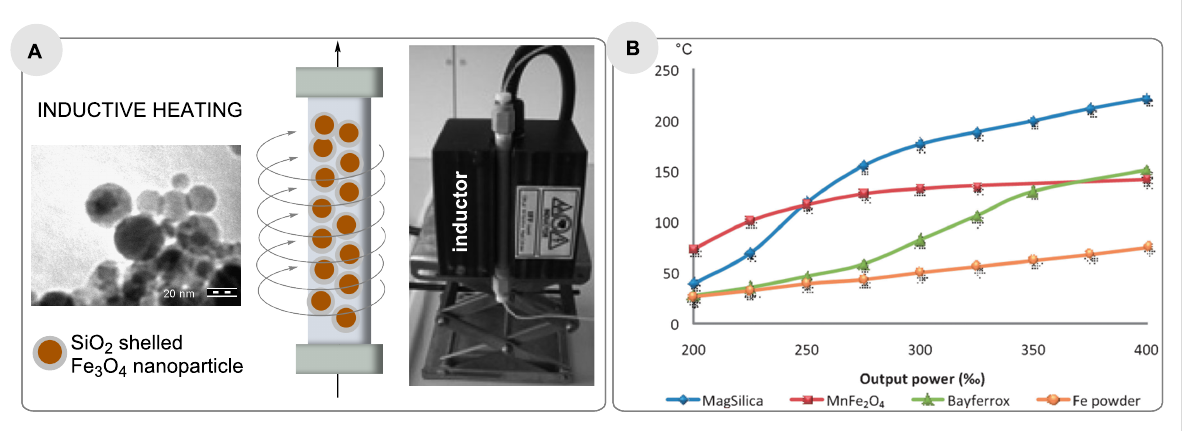
Figure 4: A. Flow reactor filled with magnetic nanostructured particles (MagSilica TM ) and packed bed reactor embedded in inductor (right); B. heating profile of different materials exposed to an electromagnetic field. Heating profiles of MagSilica TM , MnFe 2 O 4 , Bayferrox TM , and iron powder.